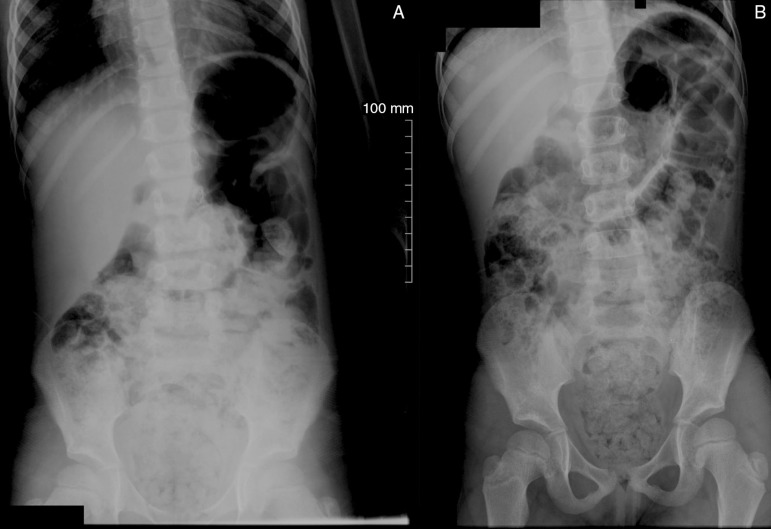
Radiografias de abdome em posição ortostática (A) e decúbito dorsal (B) em
que se observa grande quantidade de fezes nos cólons ascendente e descendente,
sigmoide e reto. Nota-se também dilatação do segmento reto sigmoide secundário
à presença das fezes.